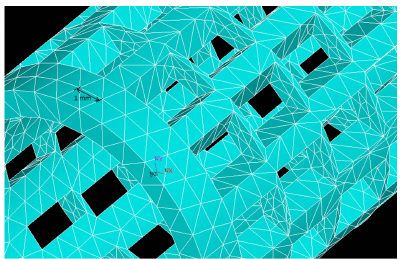
Figure 9. Defining a finite element mesh.